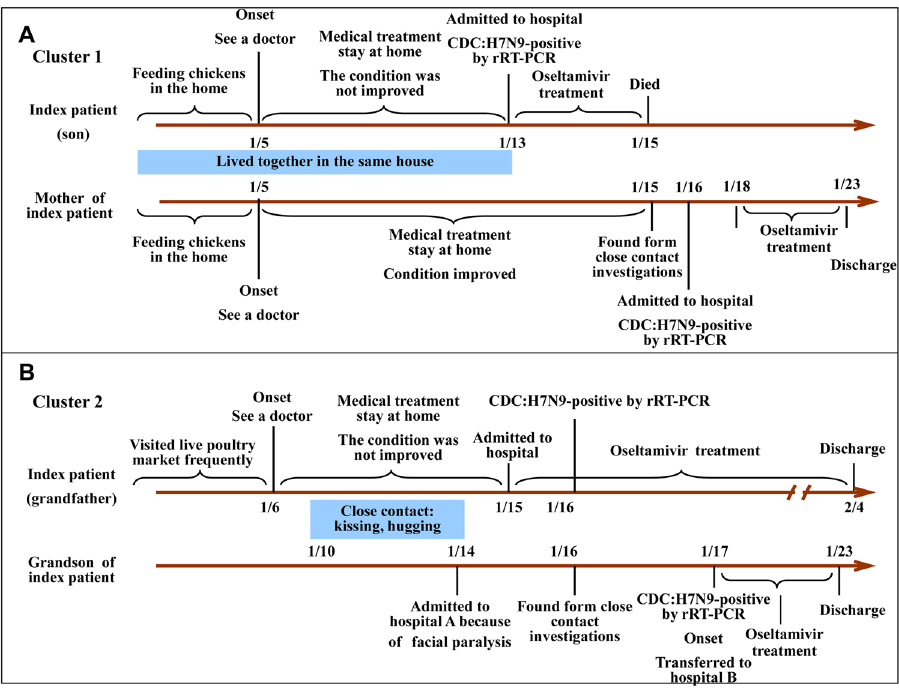
Figure 1. Time lines for two family clusters of H7N9 virus infection in Fujian, Southeast